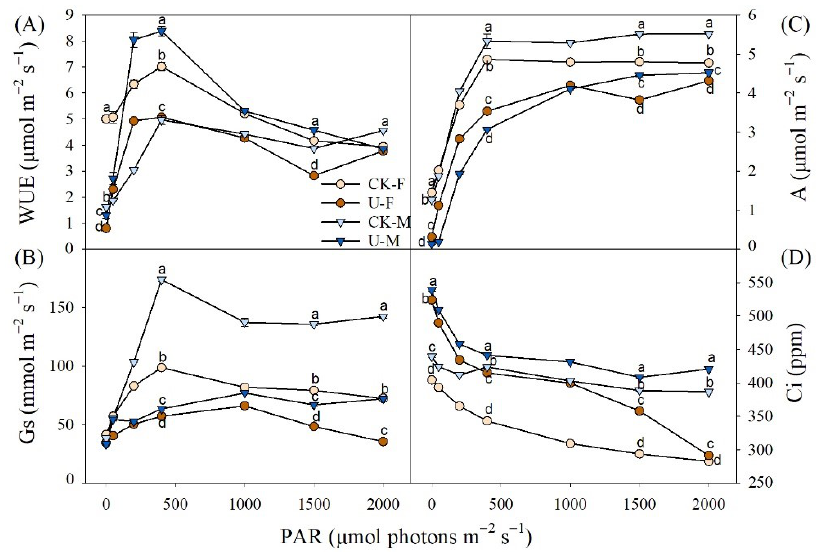
Figure 2. Gas exchange parameters of P. cathayana under U stress: water use efficiency (WUE) ( A ), stomatal conductance (Gs) ( B ), net photosynthetic rate (A) ( C ) and intercellular CO2 concentration (Ci) ( D ). Values are expressed as means ± SE ( n = 3). Different letters represent significant differences between treatments ( p < 0.05).